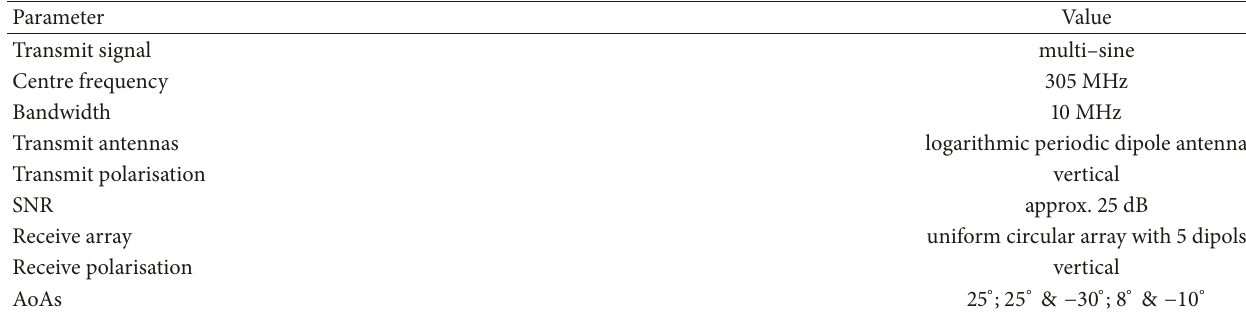
Table 4: Setup for the test measurements.